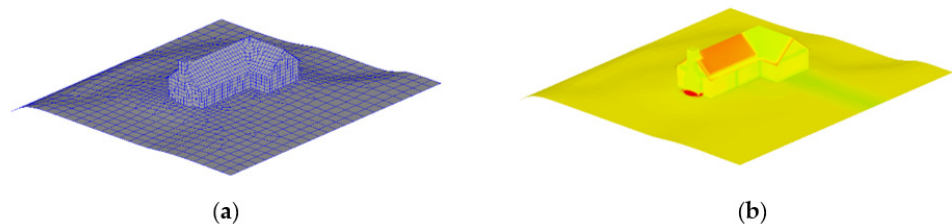
Figure 12. Complex house model with 5660 patches and 30 parts: ( a ) geometric structure; ( b ) tem- perature field distribution at a given moment. Table 4. MTPHNet’s generalization performance for temperature field prediction of complex ob- jects.